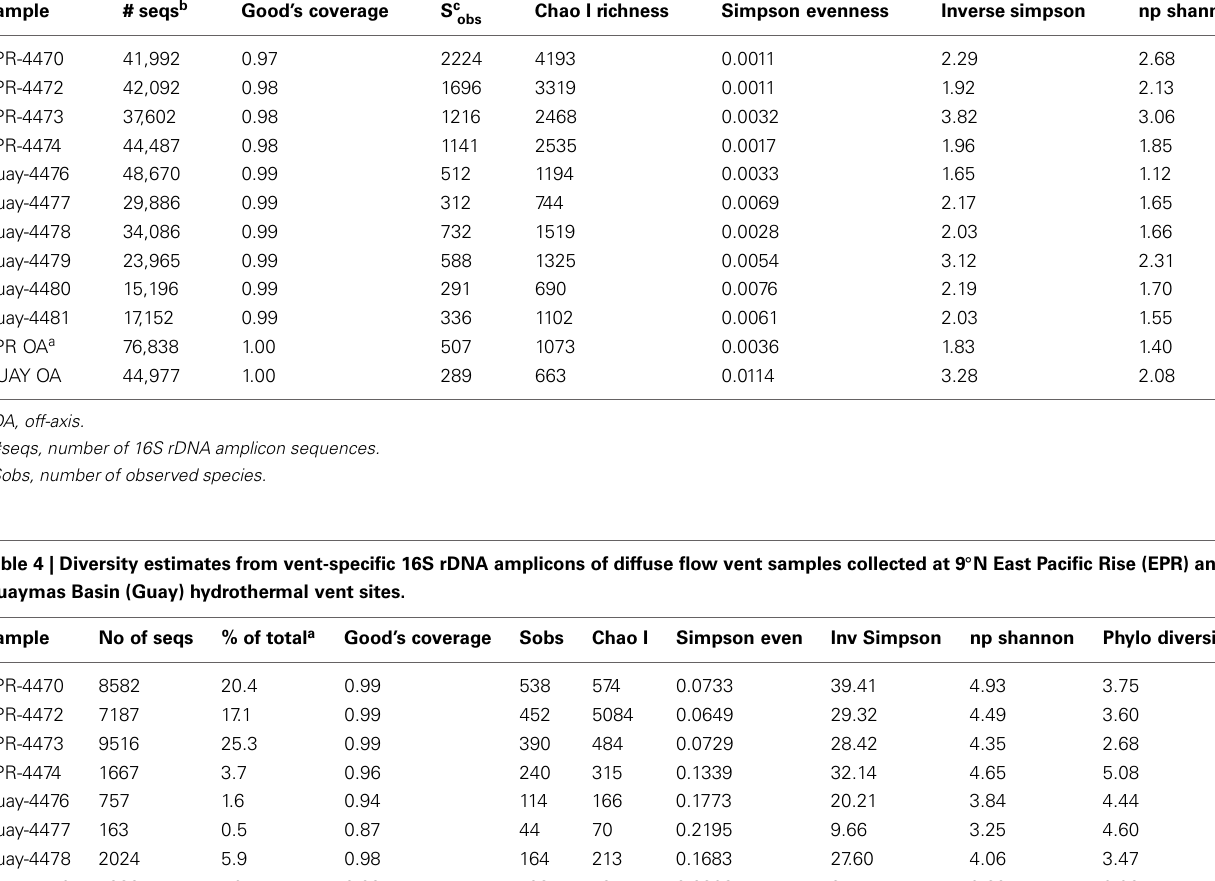
a Percentage of total library that were considered as vent-specific sequences. b Based on phylogenetic distances of 200 sequences